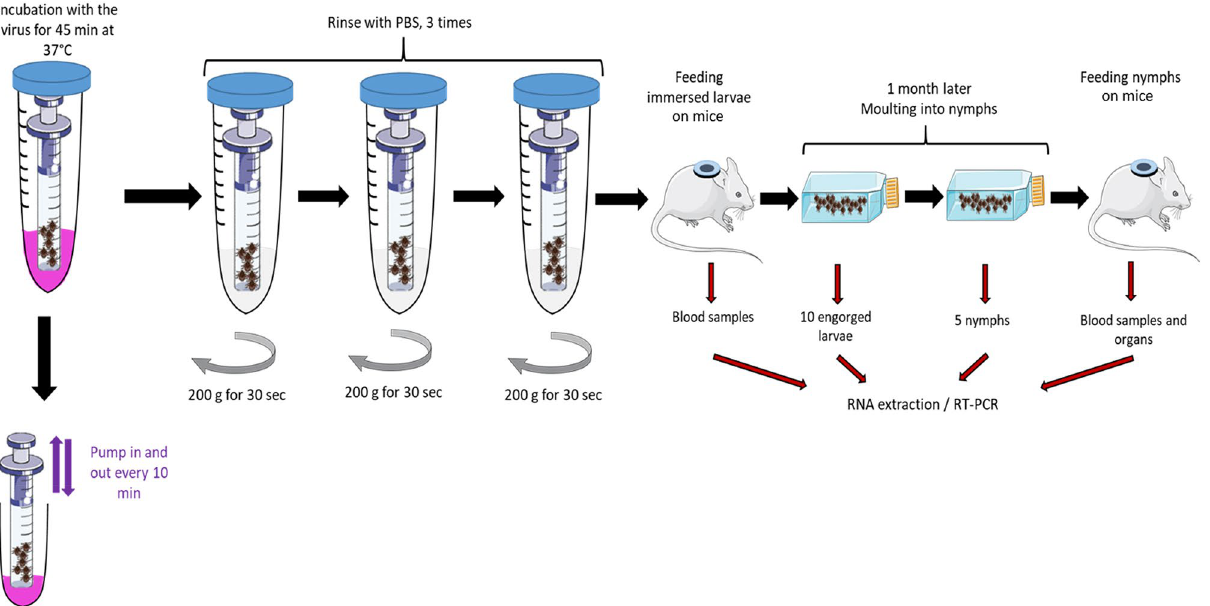
Figure 5. Schematic representation of the immersion technique used to infect ticks with KEMV and TBEV (adapted from 14,20 ). Methods used to infect larval